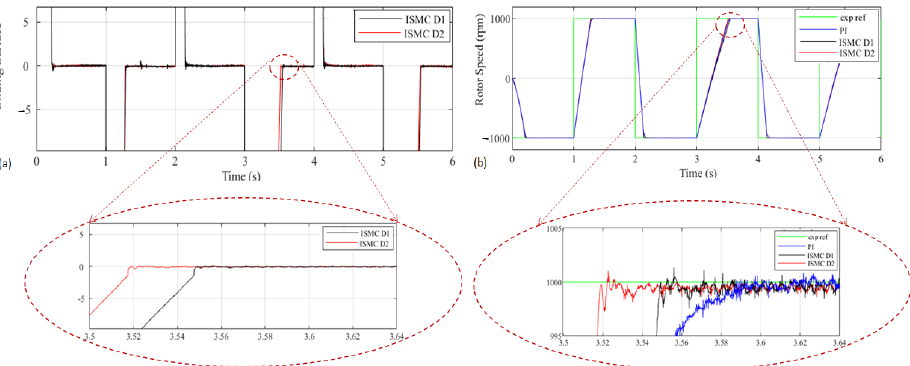
Figure 4. Experimental tests for performance comparison between the proposed ISMC (D2 design) regulator and the conventional ISMC by using 1000 rpm reference speed (D1 design) and also with PI